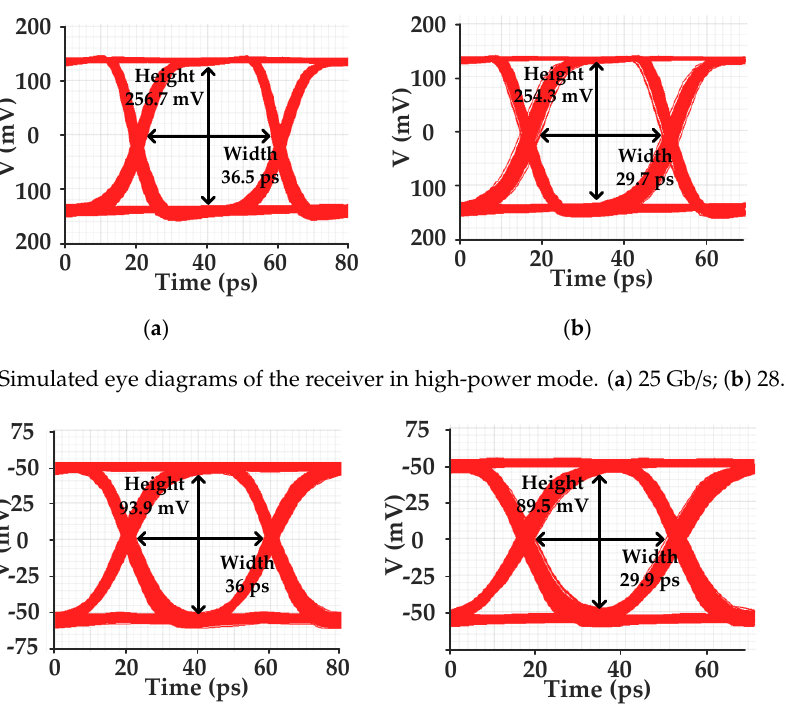
C = ±3.8 % Figure 15. The simulated voltage variation of the total parasitic capacitance.